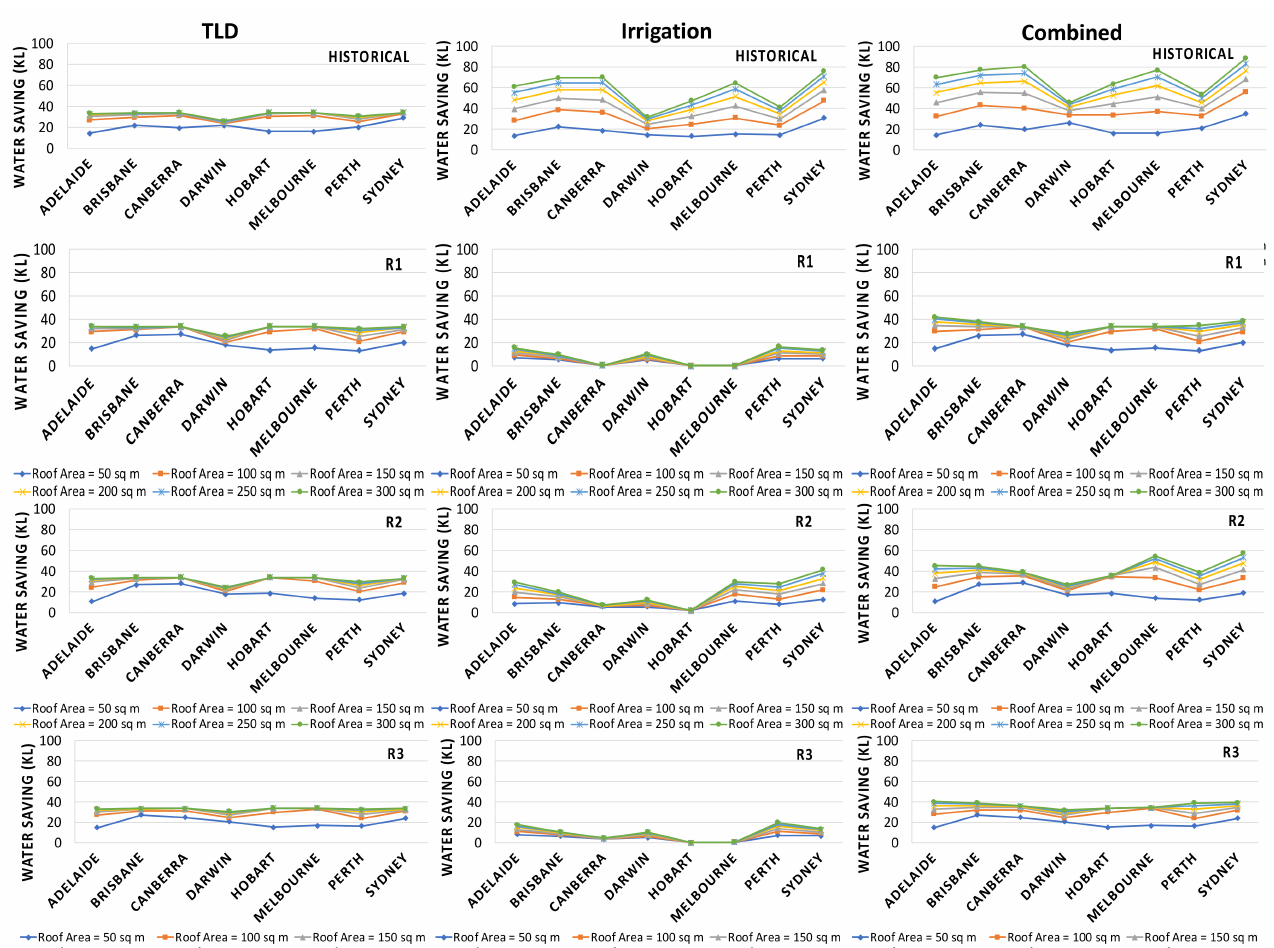
Figure 11. Average annual water saving–roof area relationships for both the historical and future period for TLD, irrigation and combined